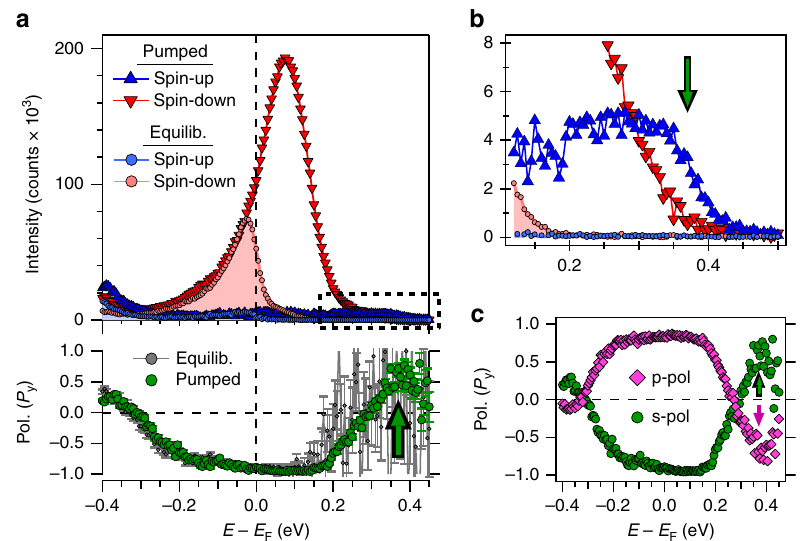
Figure 2 | Spin resolved spectra at a fixed emission angle beyond k F . ( a ) The pump excitation allows spin analysis to be performed well above the Fermi p (cid:3) (cid:4) (cid:2) 1 energy E F . The error bars shown in the spin polarization P y are statistical error bars, calculated as D P y ¼ S eff ffiffiffiffi N , where S eff ¼ 0.2 is the effective Sherman function of the spectrometer and N is the total number of recorded counts. The error bars for the equilibrium measurement (gray) increase rapidly above E F due to the low number of counts from the low occupation in equilibrium. Only once states above E F are populated through pumping can a reasonable measurement be made. ( b ) Upon zooming in, it is apparent that polarization ( P y ) reverses at E (cid:2) E F E 0.3eV within the pumped ( D t ¼ 0.7ps) spectrum. ( c ) The measured spin-polarization reverses sign when measured with s - and p - polarized probe photons. In both cases the pump is p -polarized.